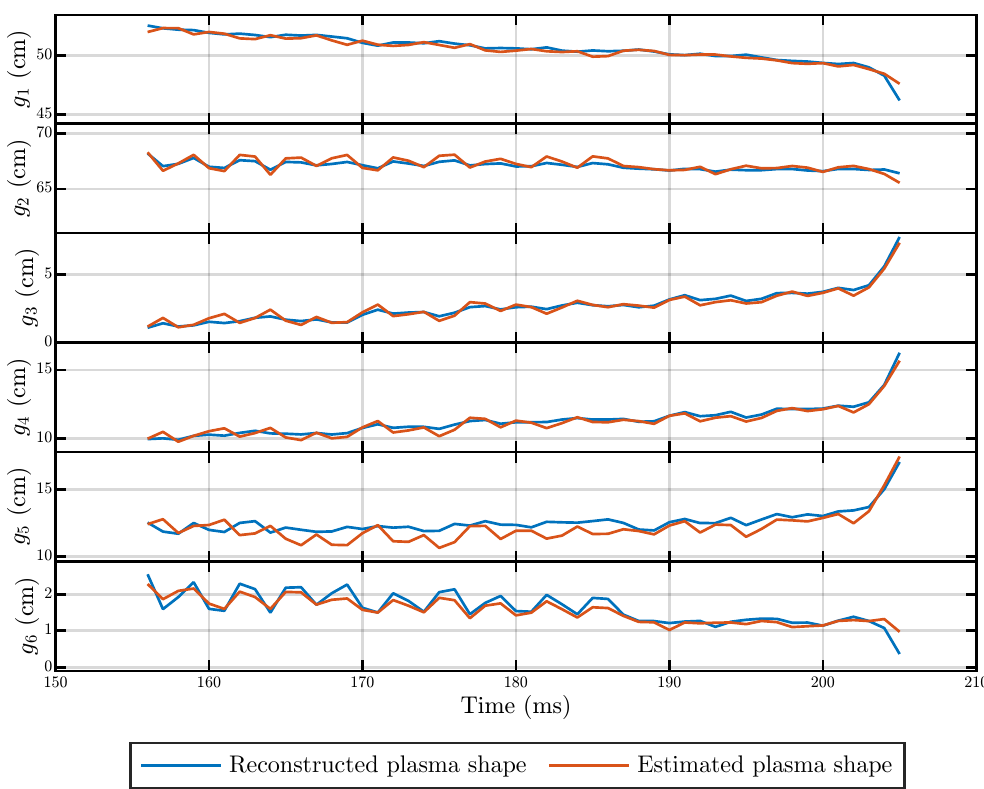
Figure 7. Estimation of the gap values in the discharge #37712 of the Globus-M2 spherical